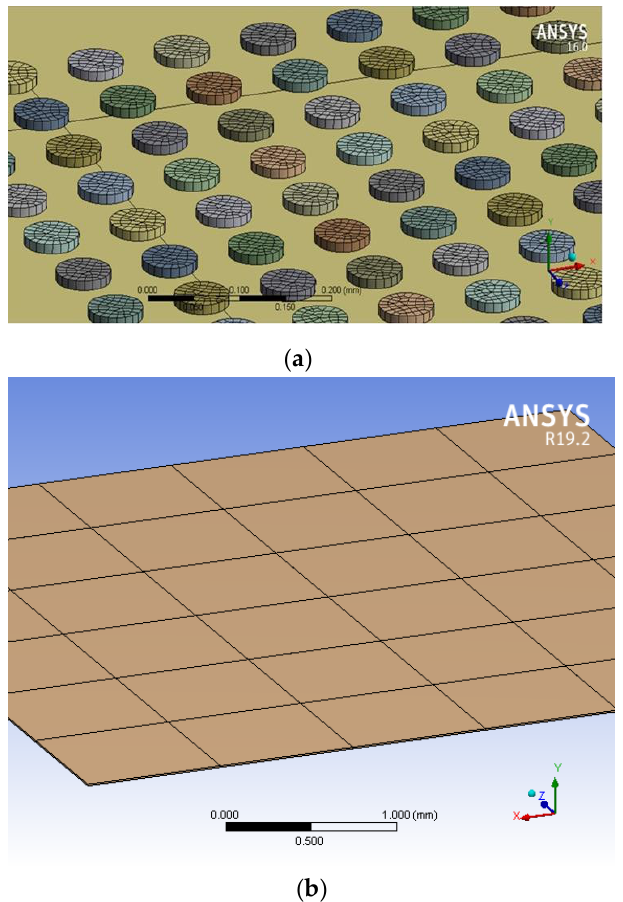
Figure 2. Meshing for simulation: ( a ) 10 μm-thick big round bumps (BRB), ( b ) 1 μm-thick Pd for Ni/Pd/Au.